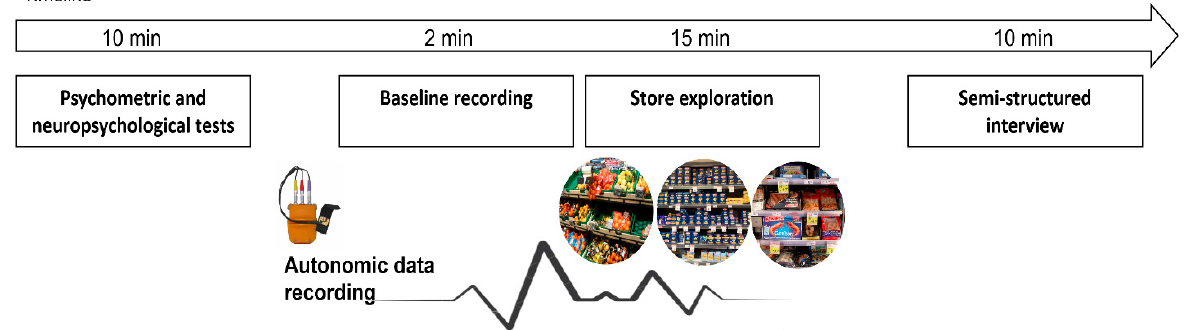
Figure 1. Procedure. Experimental setting with autonomic measures recording during in-store ex- ploration.